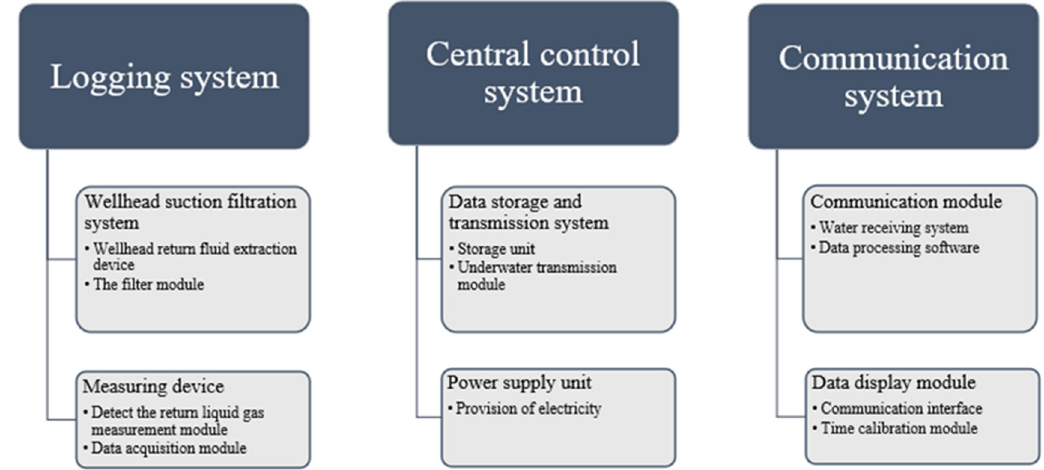
Figure 2. System architecture diagram.